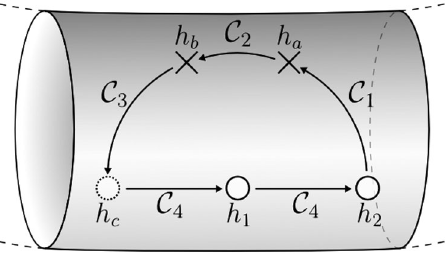
FIG. 7. Exchange path for two quasiholes. First, the quasihole is dragged along path C to h . There the coherent state at h a 2 1 representation is changed from the original basis to the dual basis is then dragged along C using Eq. (34). The quasihole at h a h , and the representation is changed back to the original basis. b is moved along C to h . At this point both The quasihole at h b c 3 quasiholes are moved to their final positions: The quasihole at h goes to h and the quasihole at h goes to h c 2 1